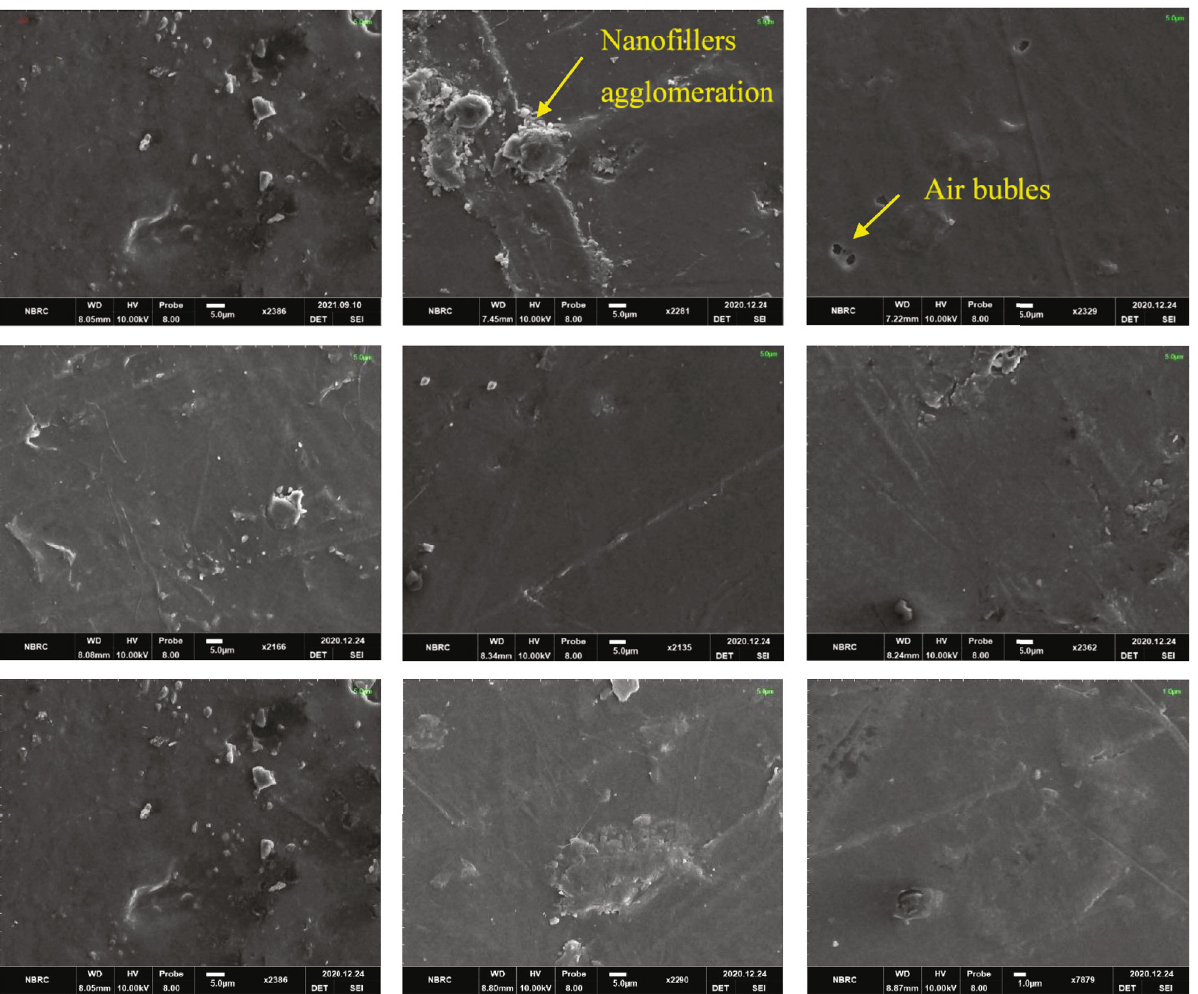
Figure 6: SEM images of carbon fi ber/epoxy composites impregnated with nano fi llers (A: MWCNTs, B: SiC, C: Gp, D: CB, E: MnO TiO , G: CoO, H: NiO, I: ZiO, and J: Fe 2